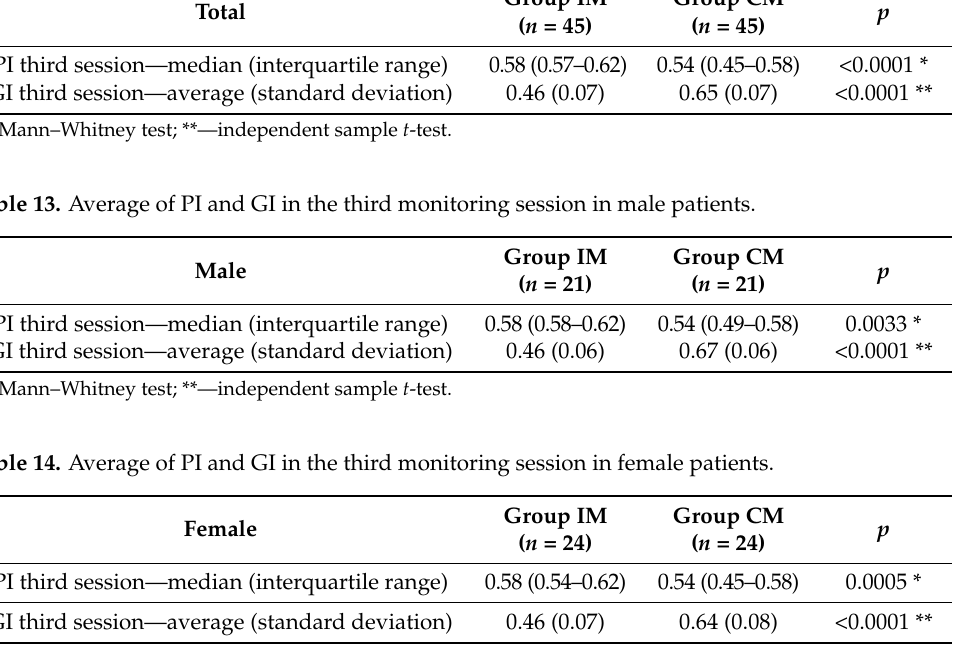
Group IM Group CM p ( n = 45) ( n = 45) 0.46 (0.07)